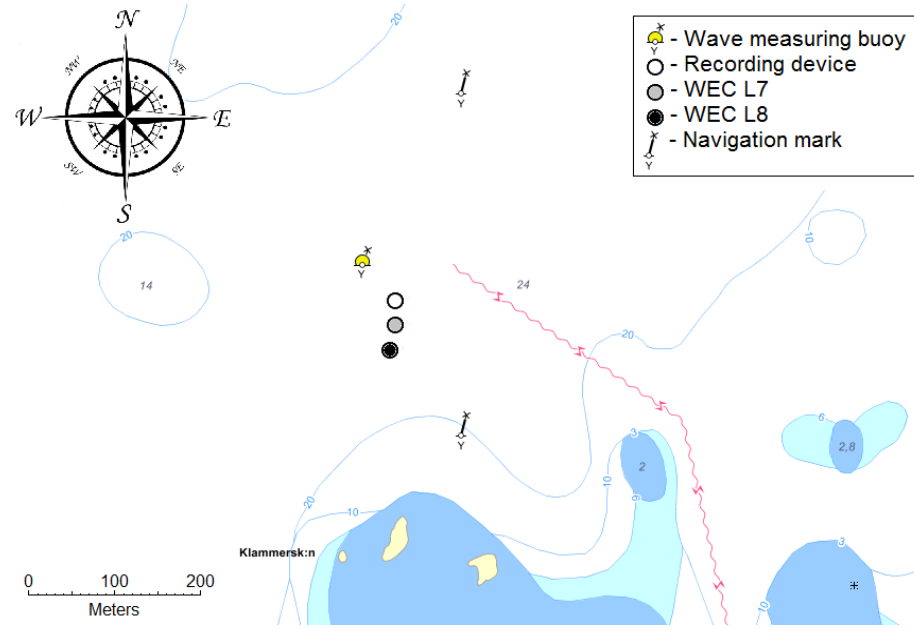
Figure 5. Map of the placement of generators and measuring equipment in the Lysekil Research Site